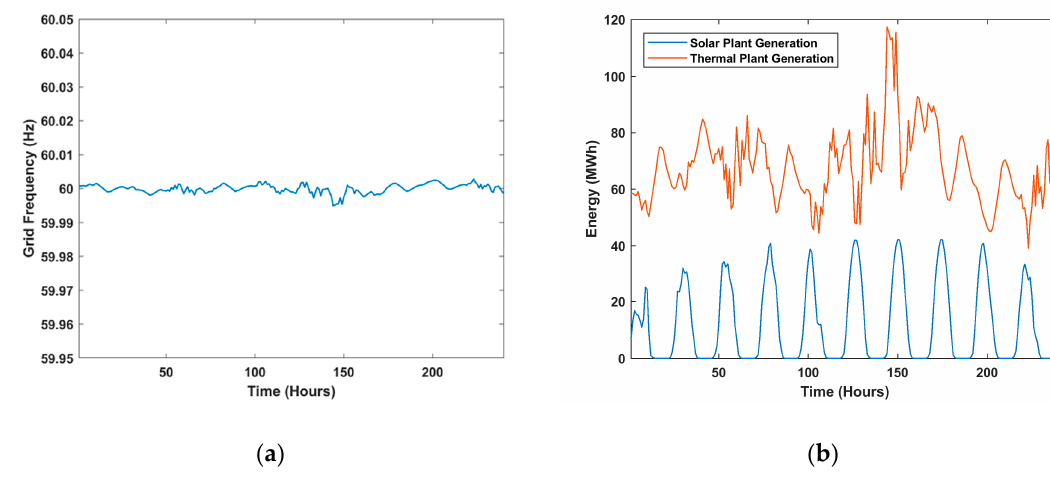
Figure 5. Frequency and generation results for 10 days. ( a ) A sample of 10 days for the grid frequency; ( b ) A sample of 10 days for the solar and thermal power generation.